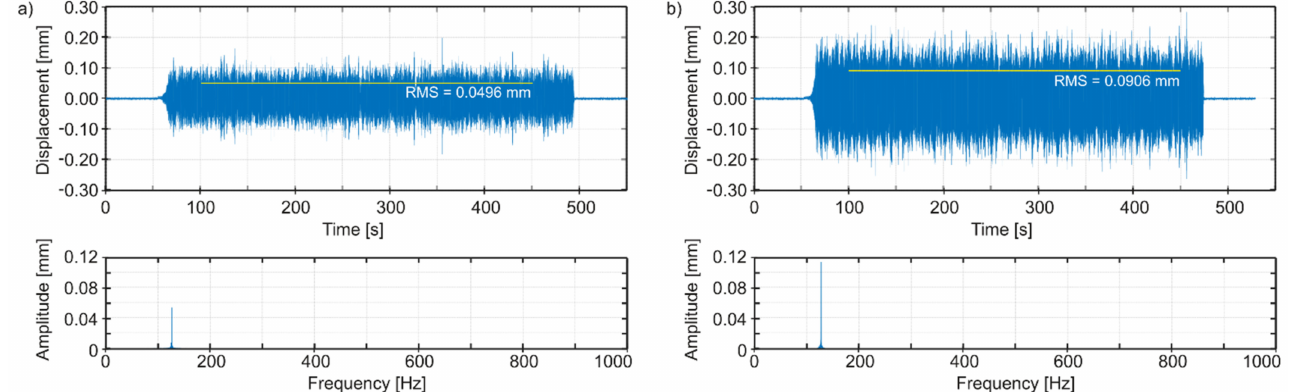
Figure 11. Simulated vibrations of the edge tip in the feed speed direction: ( a ) the best spindle speed n = 120 rpm, ( b ) adverse spindle speed n = 125 rpm.